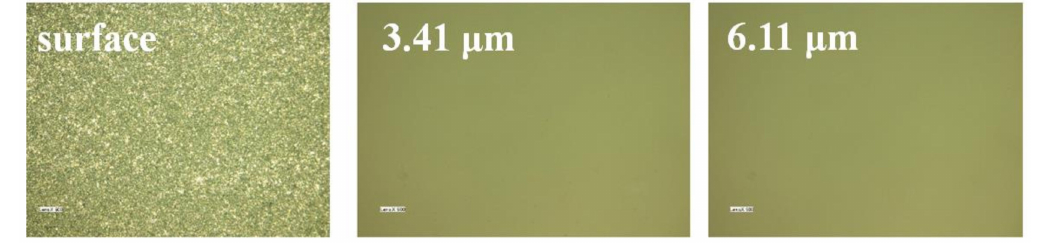
Figure 12. SSD results of sample